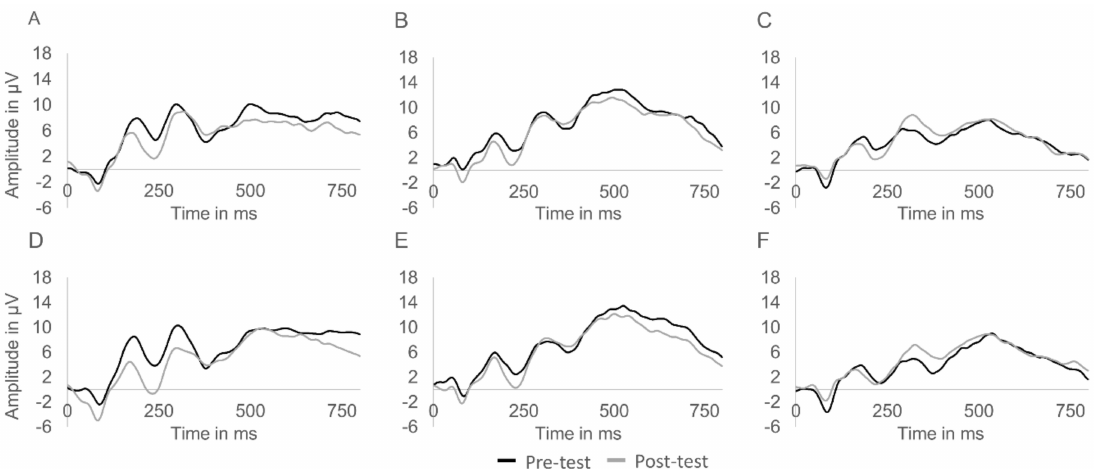
Figure 2. Centroparietal event-related potential waveforms of the aerobic (( A ) congruent trials; ( D ) incongruent trials) and coordinative training (( B ) congruent trials; ( E ) incongruent trials) groups as well as the control group (( C ) congruent trials; ( F ) incongruent trials) at pre- and post-test. Note: Waveforms were pooled from Cz, Pz, Cp1, and